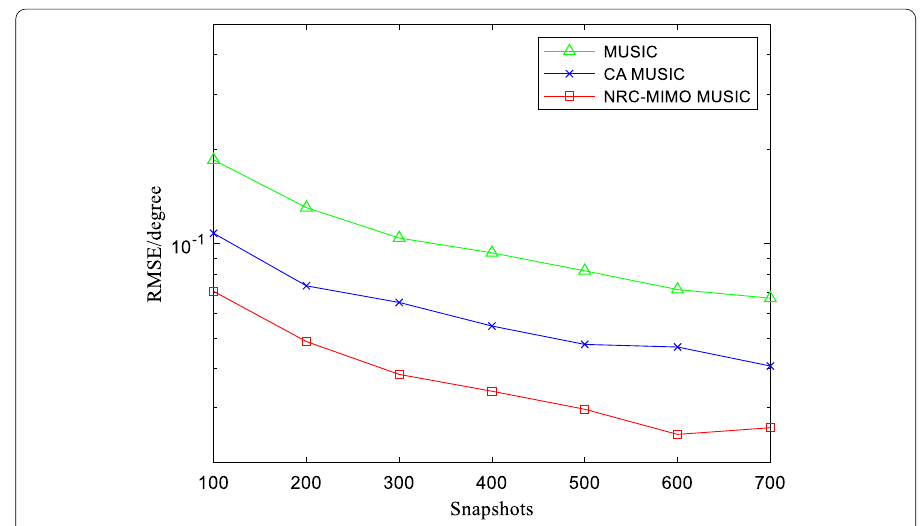
Fig. 6 Estimated performance changes under different